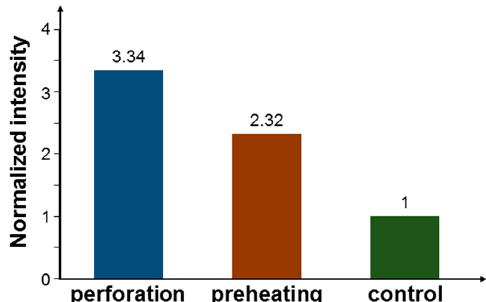
Figure 13. Normalized AlPcS fluorescence intensities based on flow cytometry measurement through the perforation and preheating processes when NRI-AlPcS is incubated with cells.